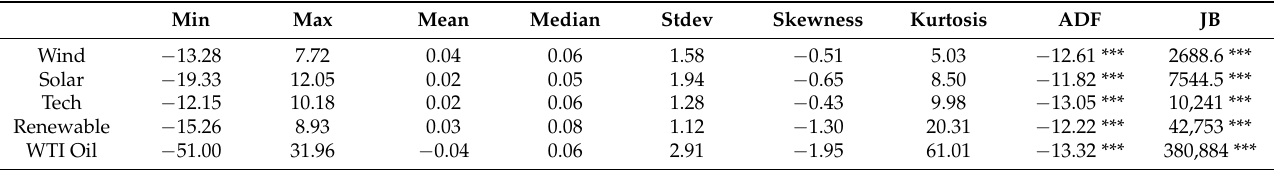
Table 1. Summary Statistics. The augmented Dickey-Fuller (ADF) statistic tests the null hypothesis of unit root. Each ADF statistic is negative and less than the test critical value at the 1% significant level, i.e., rejecting the null hypothesis of a unit root in each return series. All Jarque-Bera statistics are significant at the 1% level, which reject the null hypothesis of Gaussian distribution of return. *** indicates statistical significance at